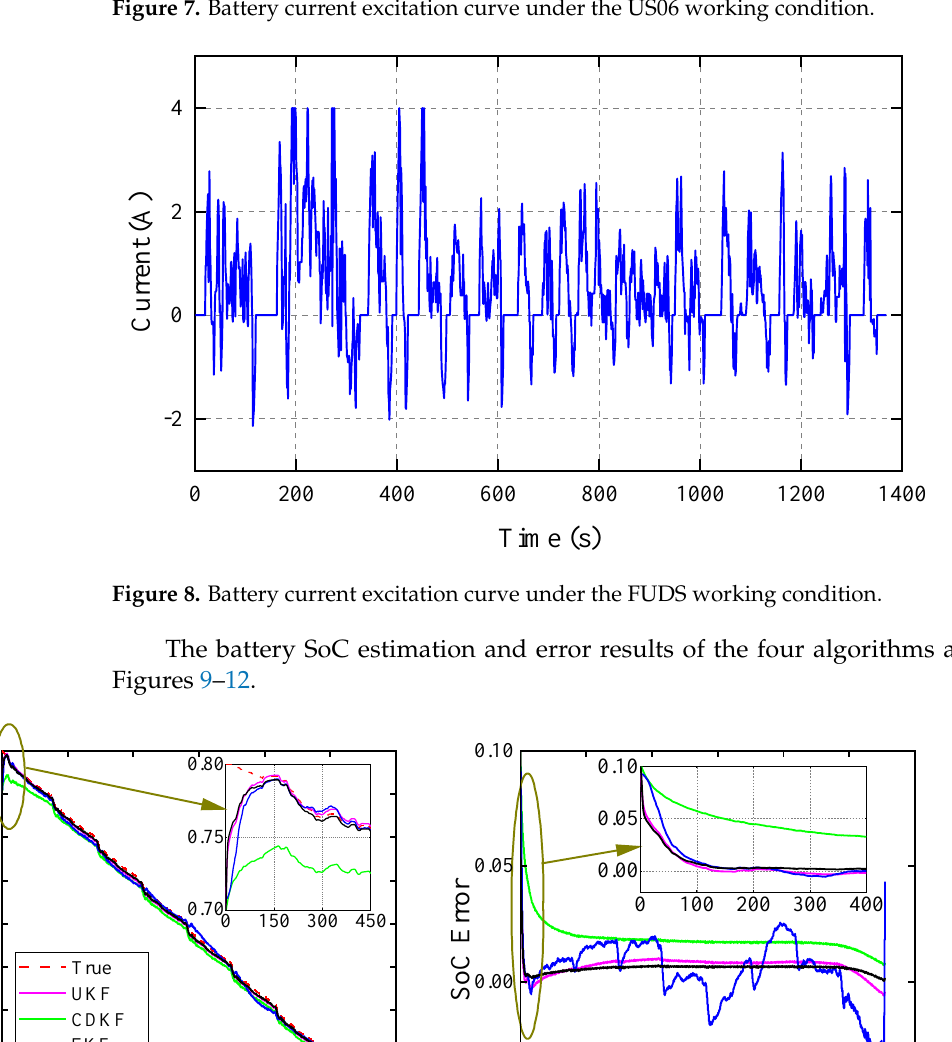
Figure 10. The initial SoC guess was 0.9 under the FUDS condition. Figure 11. The initial SoC guess was 0.7 under the US06 condition.